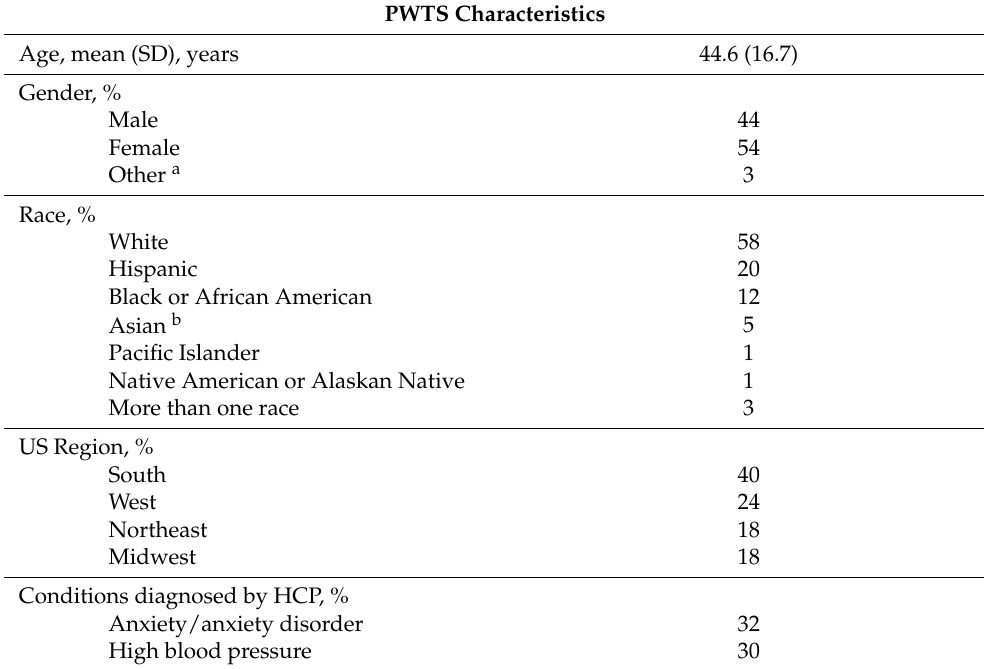
Table 1. PWTS and HCP demographic